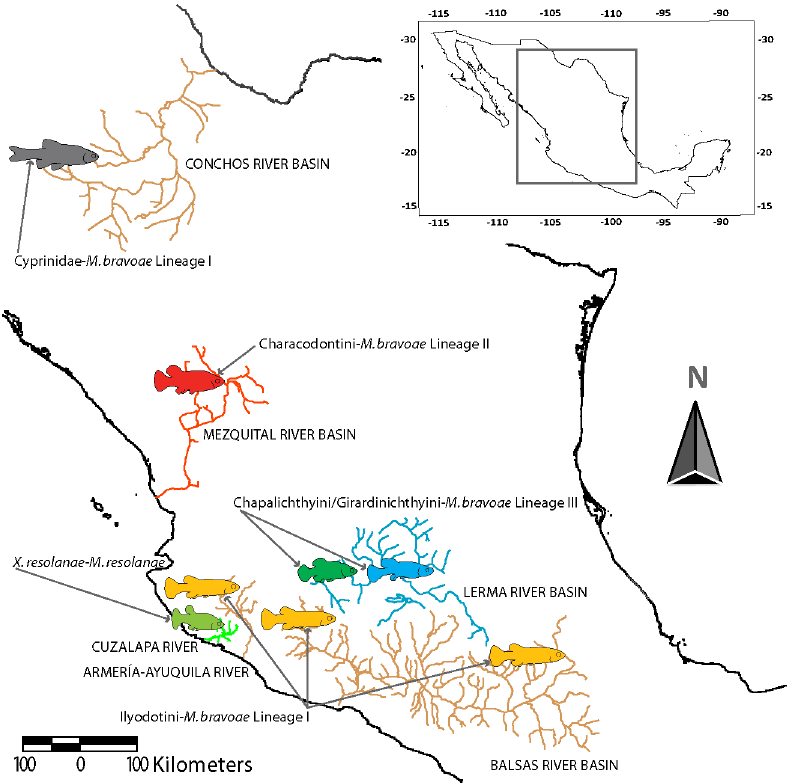
Figure 1. Pattern of geographic distribution of Margotrema spp. and their associated goodeins from central Mexico. Hydrological systems in colours correspond to distributions of each lineage of Margotrema spp. collected in this study: green = Margotrema resolanae ; orange = Margotrema bravoae Linaege I; blue = Margotrema bravoae Linaege II; red = Margotrema bravoae Linaege III. Coloured fish outlines correspond to the family/tribe(s)/species associated with each Margotrema lineage: grey fish = Cyprinidae (in Codoma ornata ); red fish = Characodontini (in Characodon audax ); yellow fish = Ilyodontini; blue fish = Chapalichthyini and Girardinichthyini; green fish = Xenotaenia resolanae (of the tribe